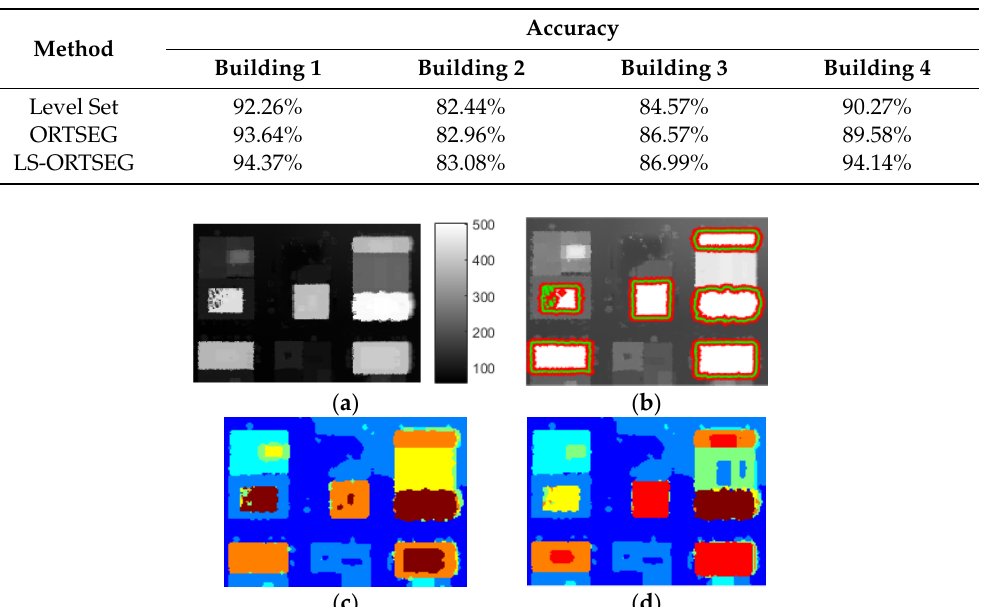
Table 2. Accuracy of different methods.